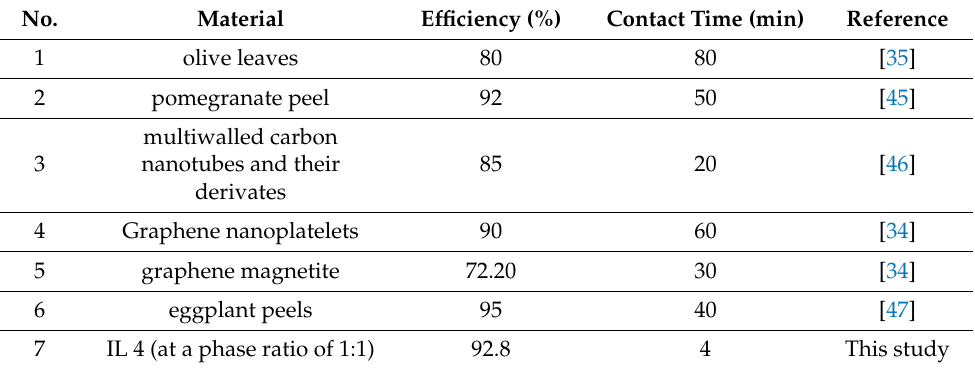
Table 4. A comparison between the reported equilibrium time and efficiency of the extraction of oil by different adsorbents using solid phase extraction and IL4 (this study) using liquid–liquid extraction.